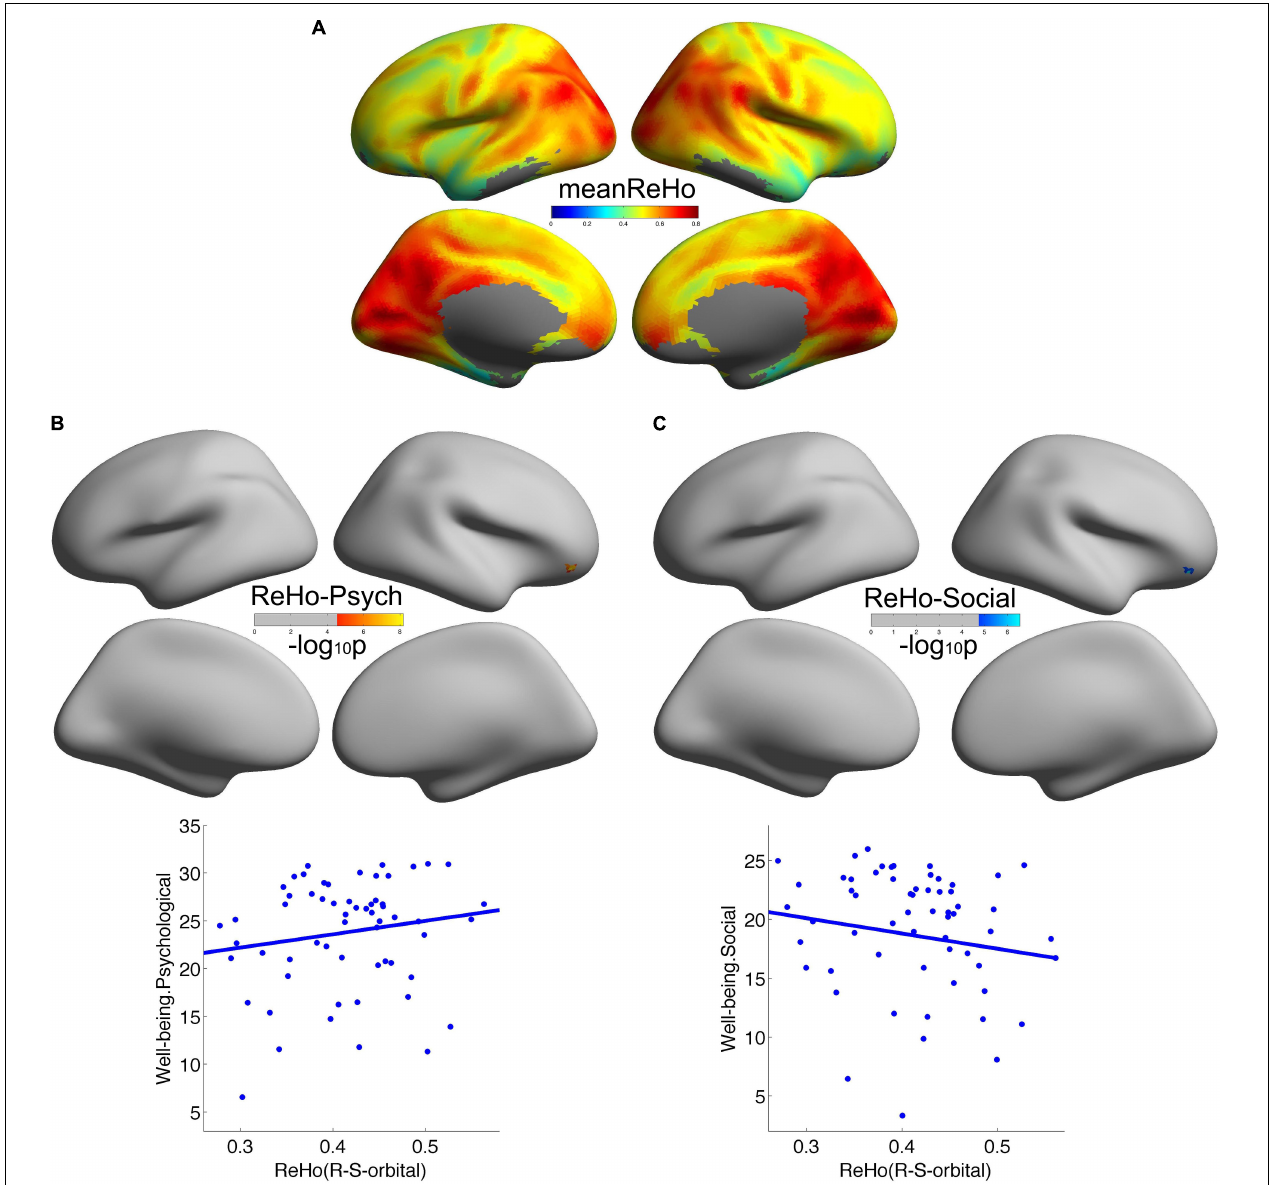
FIGURE 1 | Local cortical connectivity in healthy participants and its associations with wellbeing. (A) Showed the average local cortical connectivity 2dReHo across all the participants. 2dReHo in the right orbitofrontal sulcus positively correlated with psychological wellbeing (B) but negatively correlated with social wellbeing (C) .